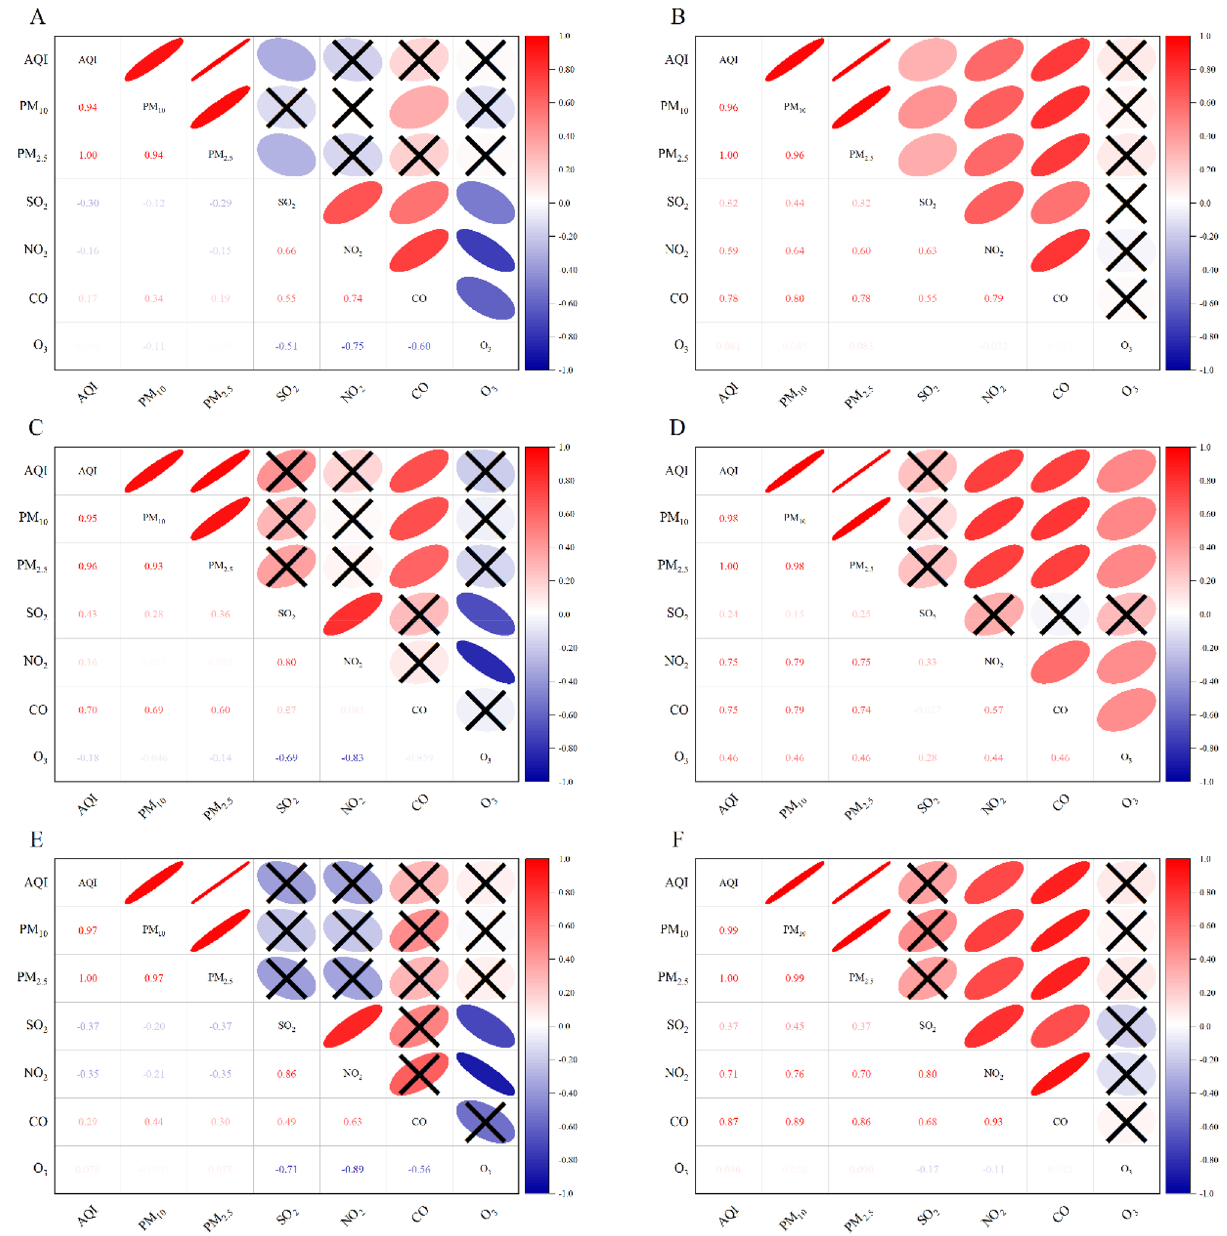
Figure 5. Pearson correlation between various pollutants during different phases and at the different regional sites during the study period. ( A , C , E ) represent the urban, urban-industrial and suburban areas in the pre- COVID period, respectively, while ( B , D , F ) represent the urban, urban-industrial and suburban areas in the COVID lockdown period, respectively. × represents a nonsignificant correlation at the 0.05